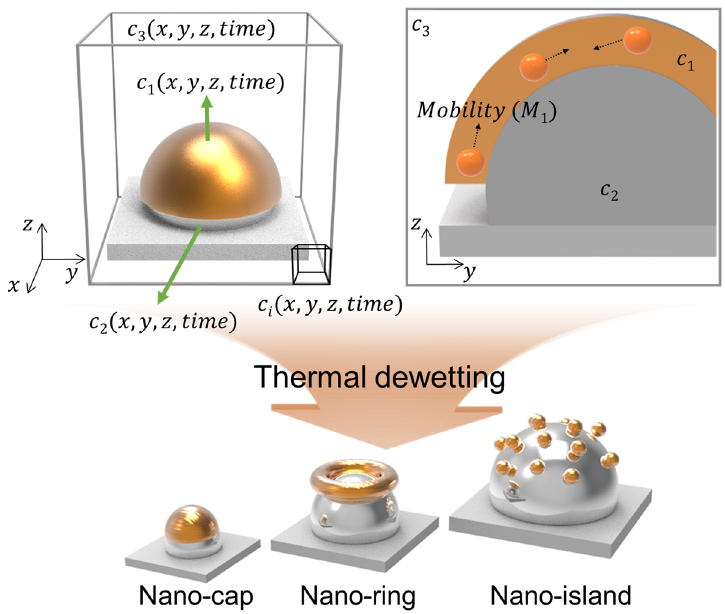
Figure 1. Schematic illustration of the proposed model to predict the equilibrium morphologies and the representative morphologies of a bimetallic nanostructure in thermal dewetting.